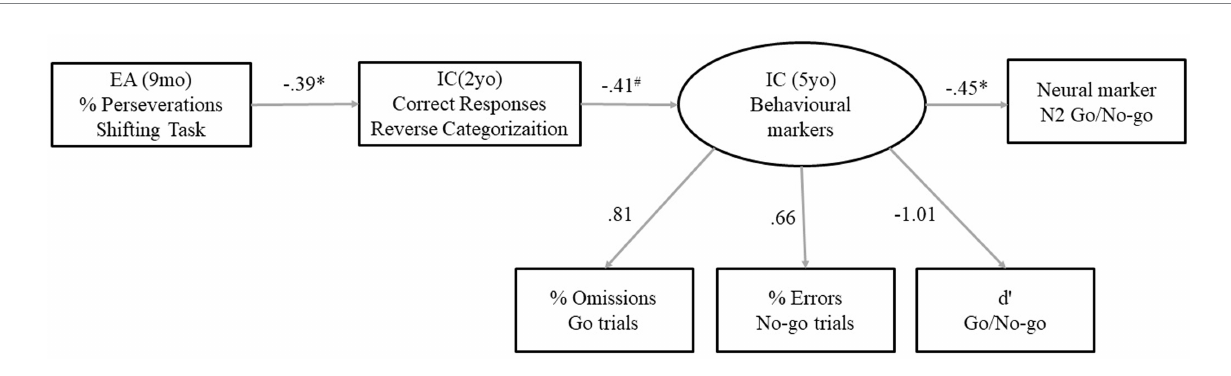
FIGURE 4 Structural equations model to predict IC at 5 years of age from EA in infancy and IC in toddlerhood.